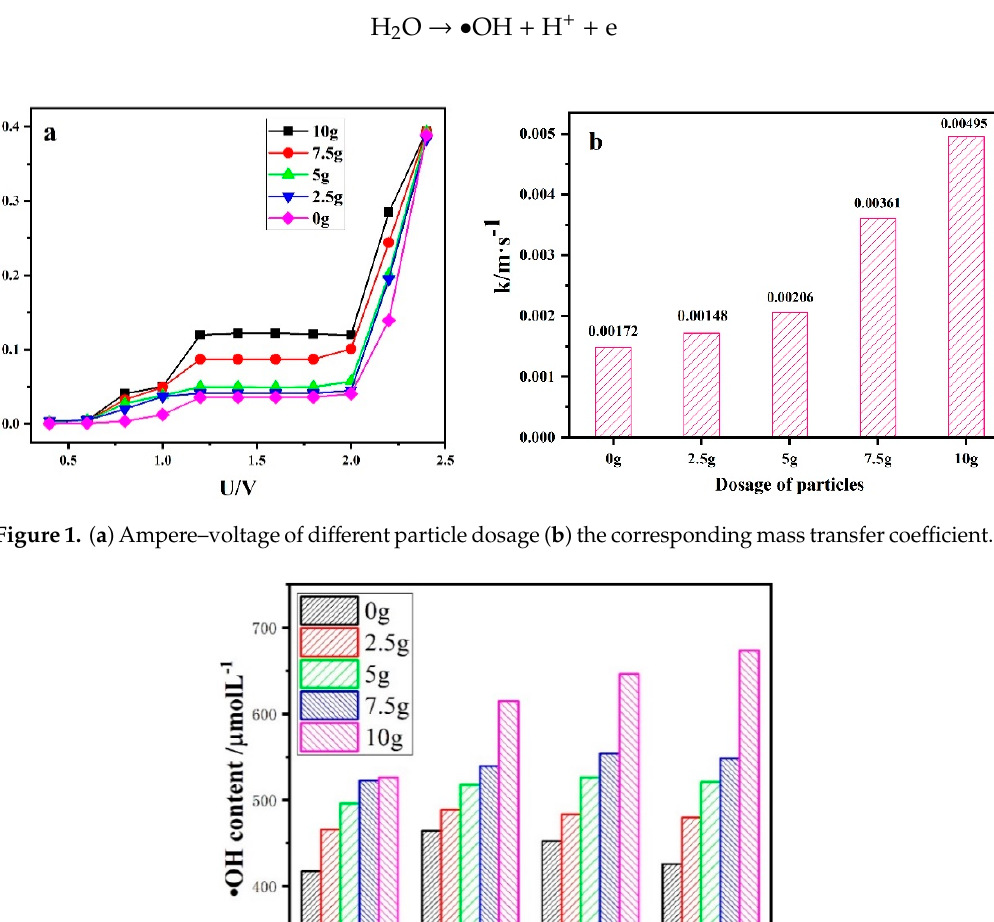
2 magnetic particle